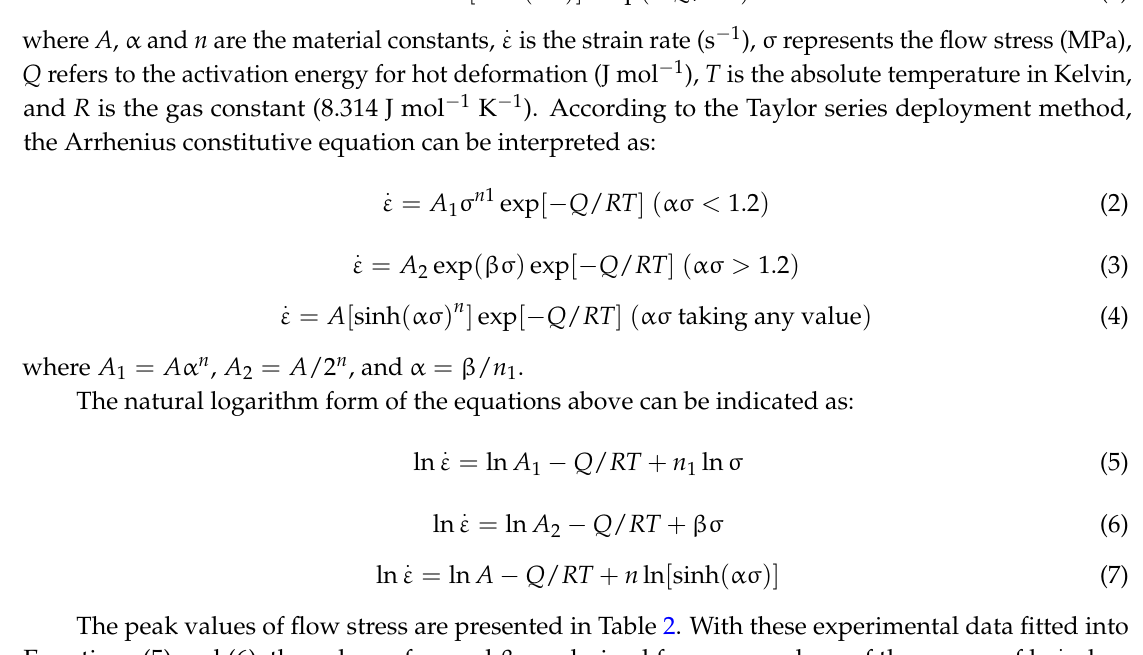
Figure 3. Typical true stress–true strain curves of 6A02 alloy at ( a )